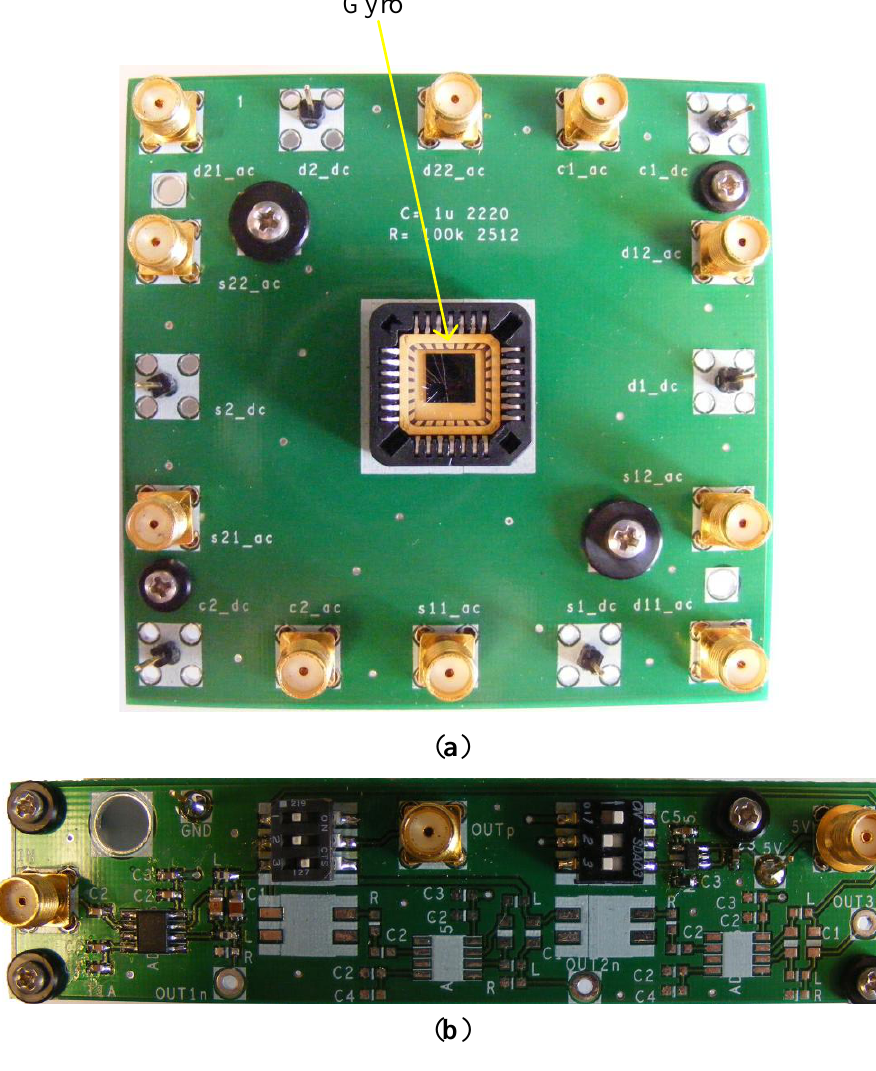
Figure 15. Photographs of ( a ) PCB with packaged gyro, and ( b ) PCB with TIA.